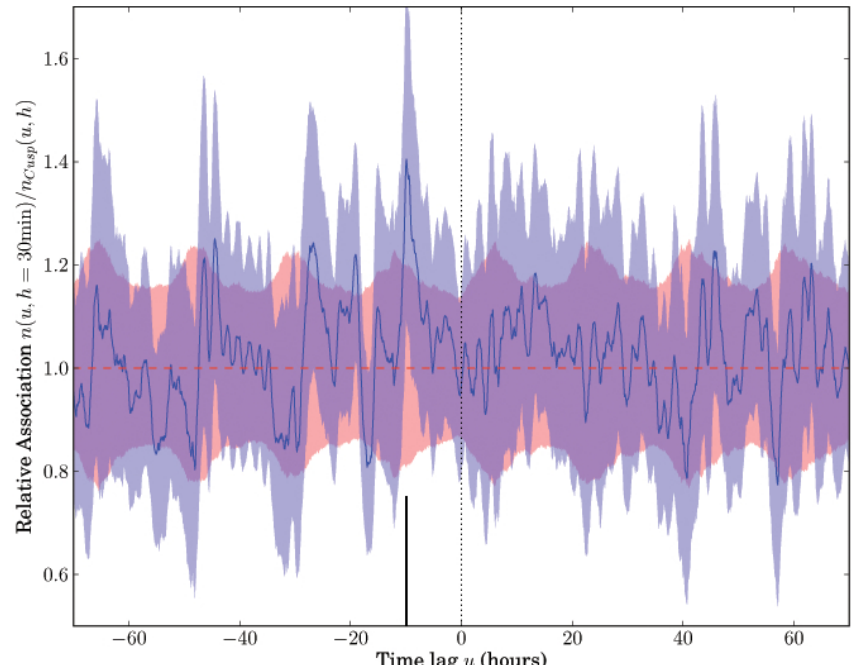
Fig. 3. Association of CEPs (blue) and cusp (red) with substorms from the Frey-Liou list. Normalized to match asymptotic association numbers and so cusp association is 1.0. Lines represent the calculated association number; shaded areas indicate 95% confidence intervals; overlapping c.i. are magenta. Heavy black lines mark features discussed in